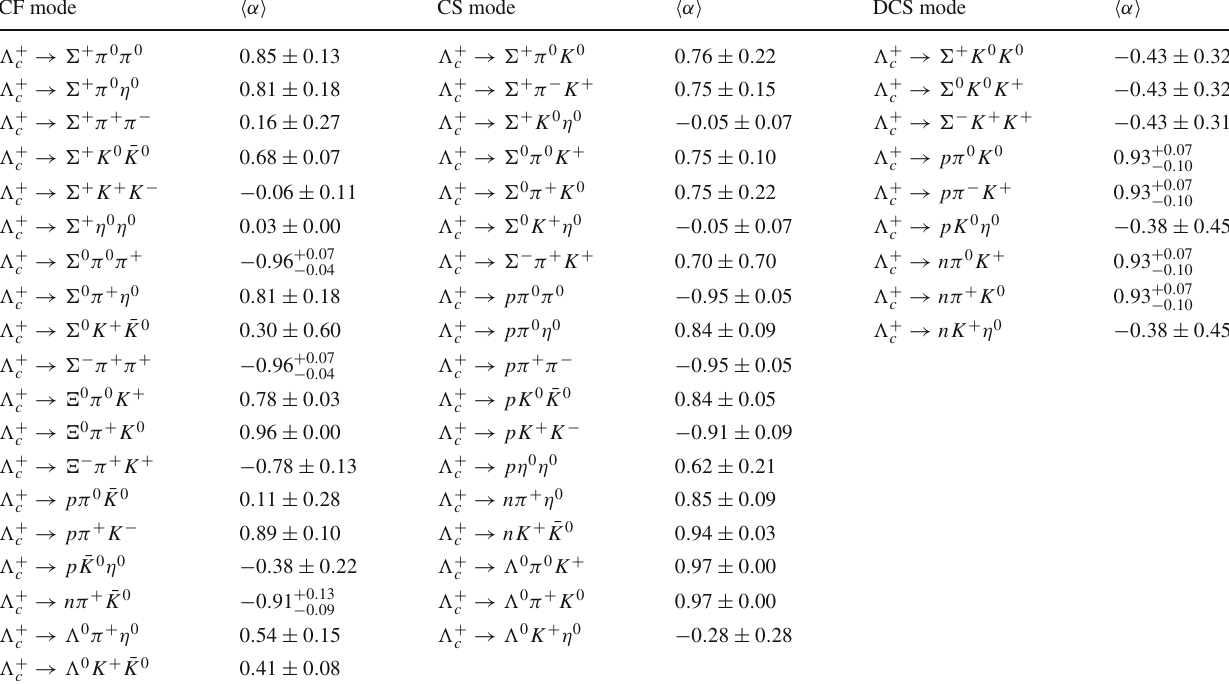
Table 9 Numerical results for (cid:8) α (cid:9) ((cid:3) + c → B n MM (cid:3) )